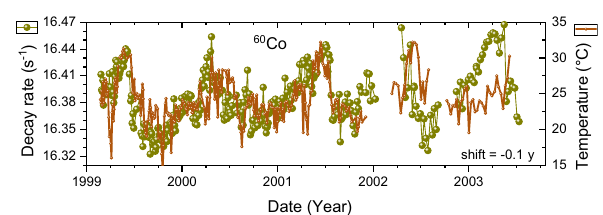
Figure 10. Averaged decay-corrected count rates of 60 Co beta decay obtained with an SBM-12 G–M counter (dots) as a function of time, compared to the inside temperature shifted in time by 0.1 year to the left